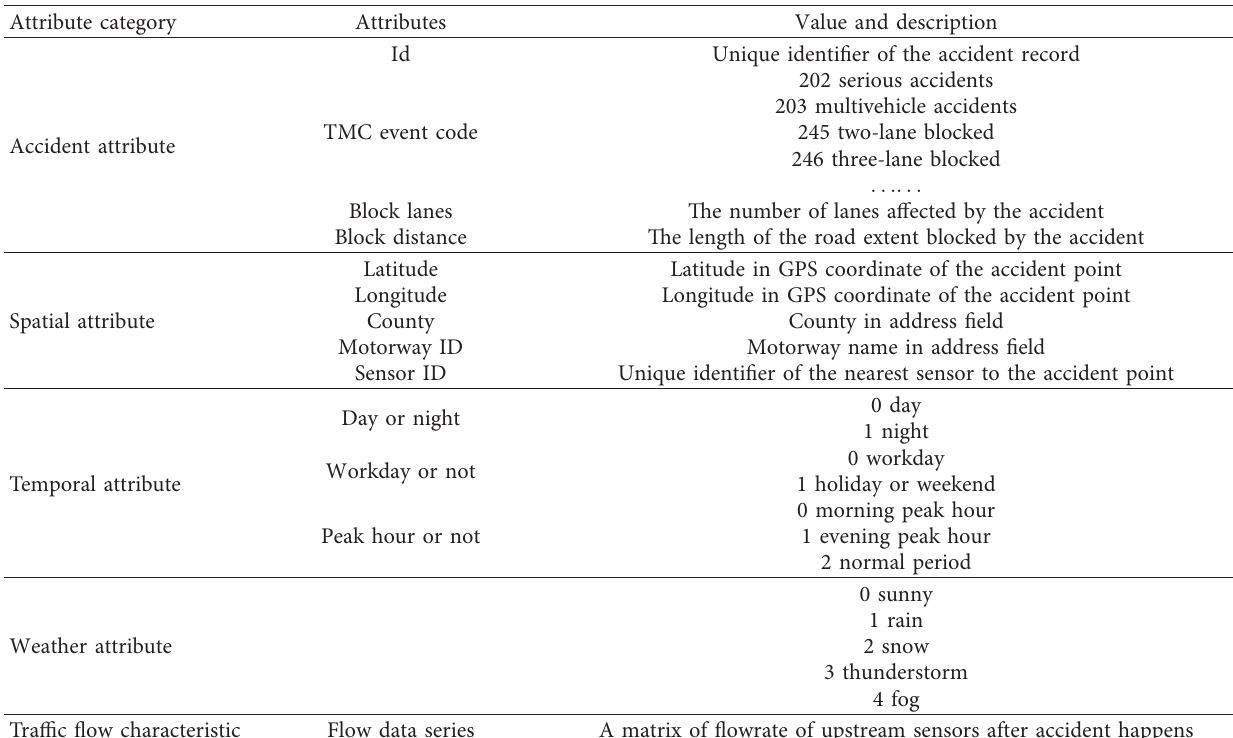
Figure 13: Distribution of accident clean-up time. Table 4: Attributes in